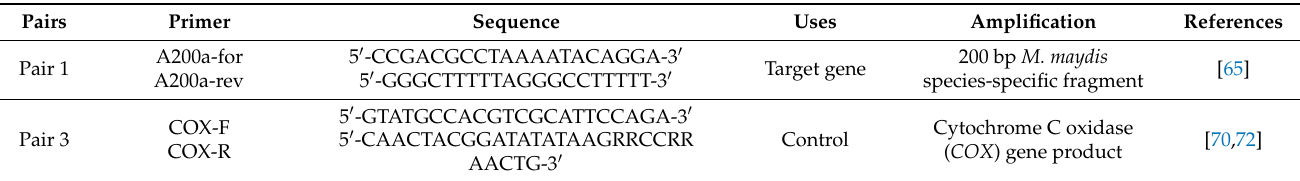
Table 3. Primers for Magnaporthiopsis maydis detection 1